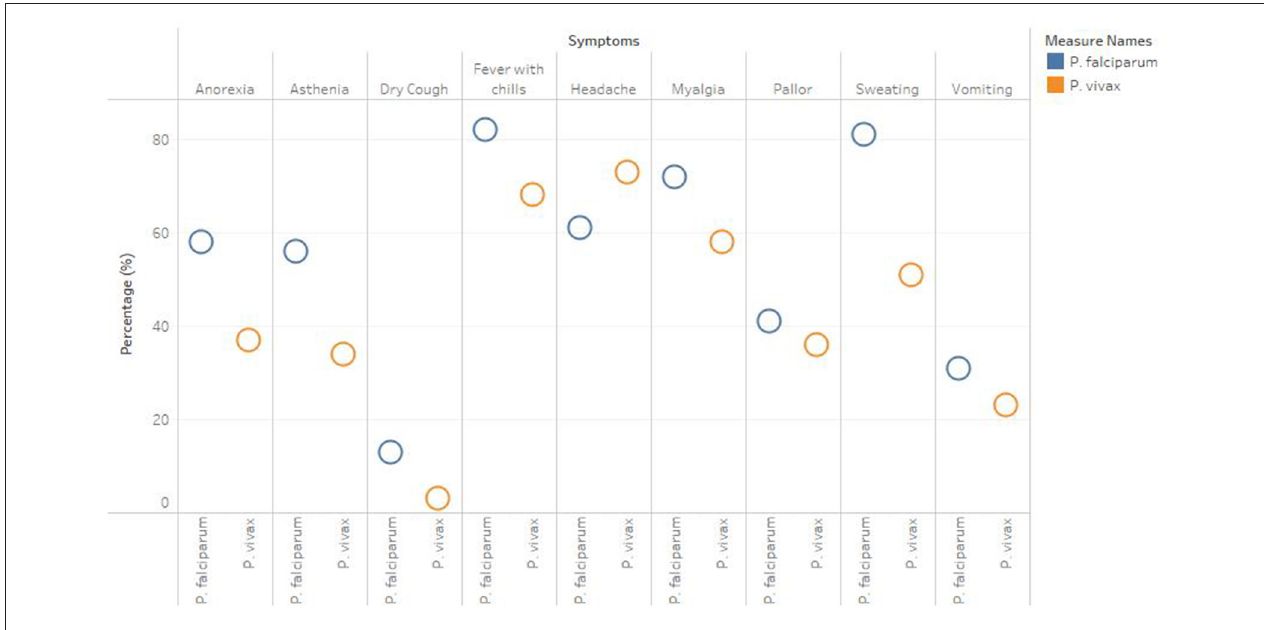
FIGURE 3 | Clinical Manifestation of P. falciparum and P. Vivax .